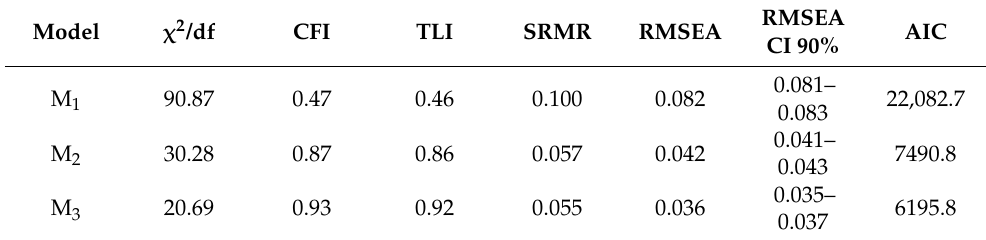
Table 4. Summary of Fit Indices for the PRIWA versions (Sample 2, N = 1309).